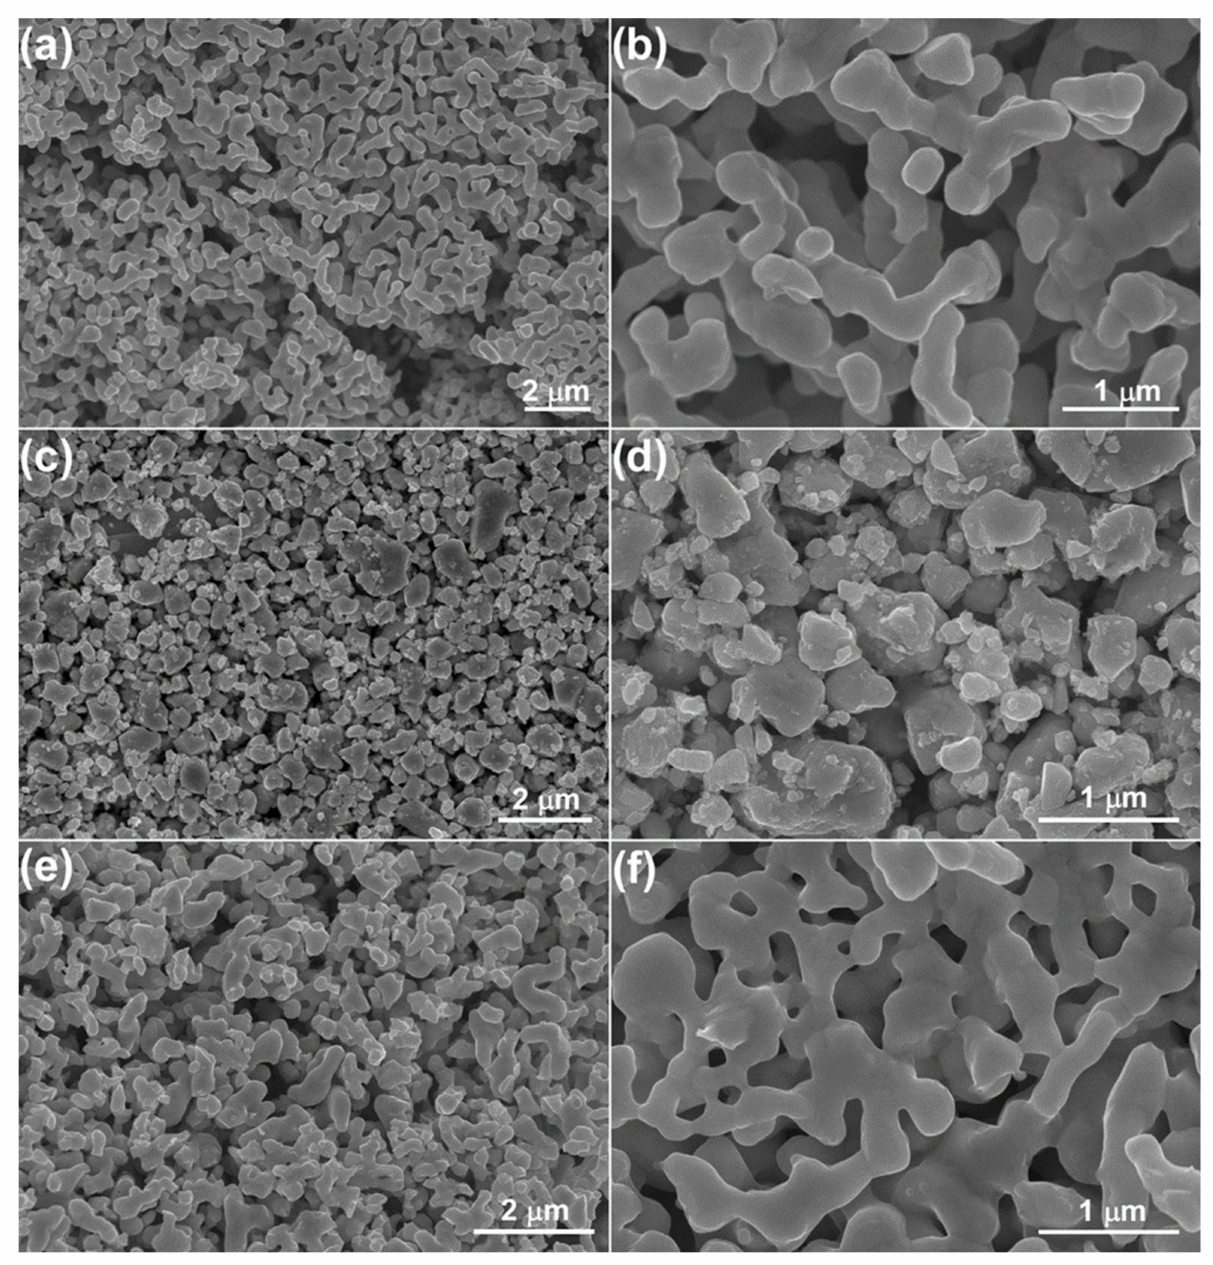
Figure 3. Low- and high-magnification SEM micrographs of the products. ( a , b ) Pr 2 Ru 2 O 7 , ( c , d ) Pr 2 Ir 2 O 7 , and ( e , f ) Pr 2 (Ru 0.5 Ir 0.5 ) 2 O 7